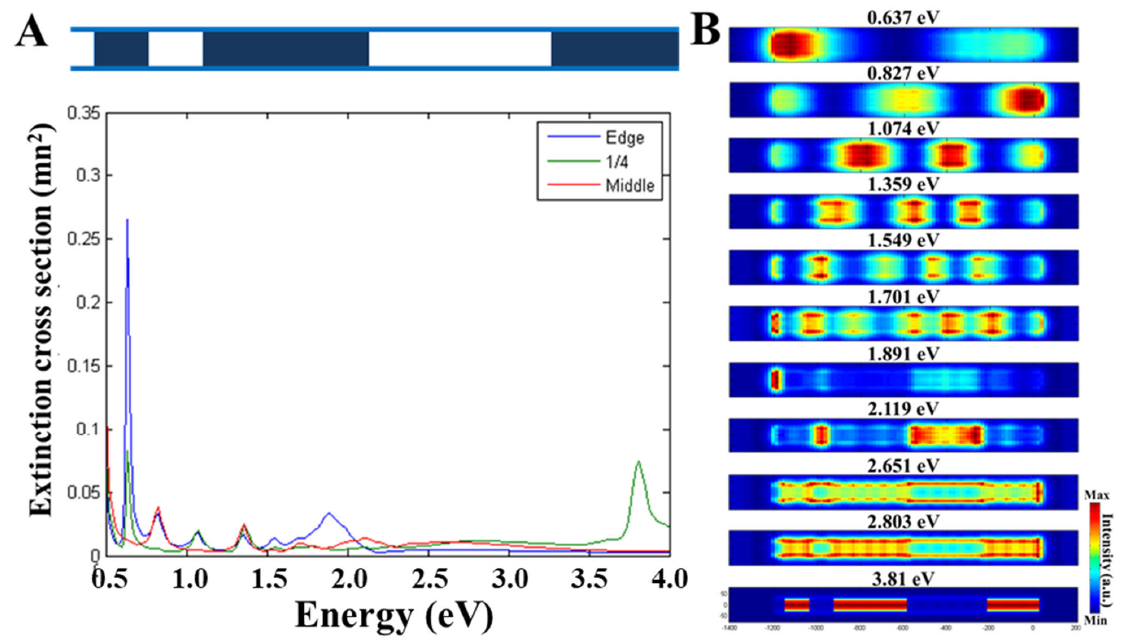
Figure 5. BEM simulations of the hybrid AuAg nanotube. ( A ) Schematic drawing of the BEM-simulated AuAg nanotube with a length of 1240 nm, a diameter of 89 nm, and 10 nm thick walls, along with the simulated local EEL spectra obtained at the tip (in blue), at a quarter of the length (at ~310 nm, in green), and at the center (at 620 nm, in red) of the AuAg nanotube. ( B ) BEM ‐ simulated plasmon maps of 11 different modes located at 0.637 eV, 0.827 eV, 1.074 eV, 1.359 eV, 1.549 eV, 1.701 eV, 1.891 eV, 2.119 eV, 2.651 eV, 2.803 eV, and 3.81 eV from the in ‐ plane view.